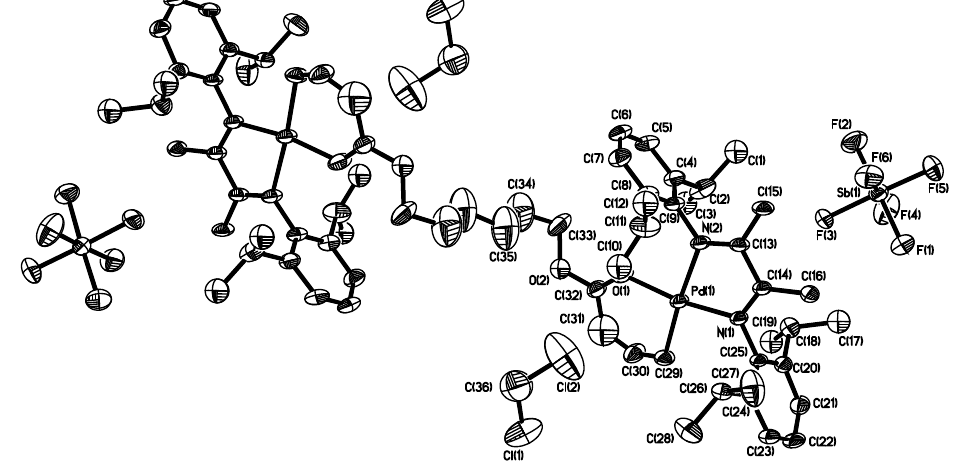
Figure 2. Thermal ellipsoid (30% probability) of 3b . Hydrogen atoms and the disordered parts of the structure are omitted. Selected bond lengths (Å) and angles (°): Pd(1)–N(1) = 2.014(3), Pd(1)–N(2) =